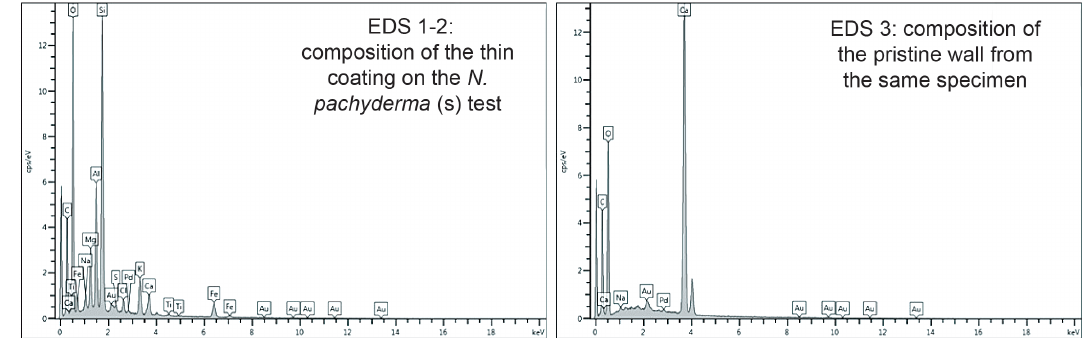
Figure 7. Left panel, EDS 1–2: energy dispersive X-ray spectroscopy (EDS) spectra of outer layer on the test of N. pachyderma (s) from the most depleted interval within CIE I (Fig. 6c) showing enrichments in Si and Mg and traces of Fe and S. Right panel, EDS 3: EDS spectra of the internal part of the wall of the same specimens (Fig. 6c) showing a pristine composition consisting of CaCO 3